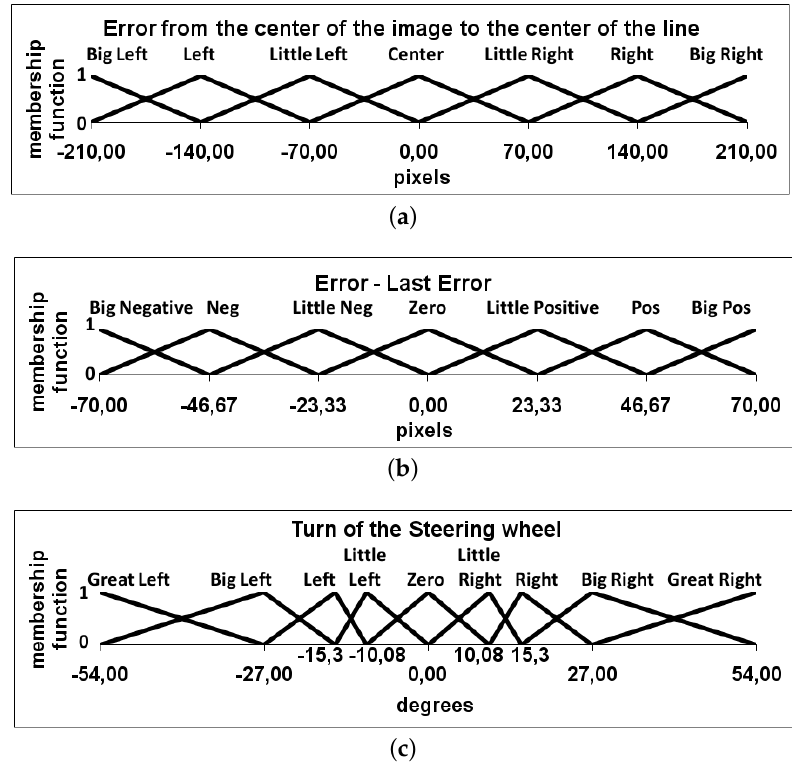
Figure 7. Definition of the two inputs and the output of the fuzzy controller. ( a ) First input variable of the fuzzy controller: Difference between the line reference and the measured line position with respect to the center of the image, in pixels; ( b ) second input variable of the fuzzy controller: The difference between the last error and the actual, in pixels; ( c ) Output variable of the fuzzy controller: The steering wheel angle, in